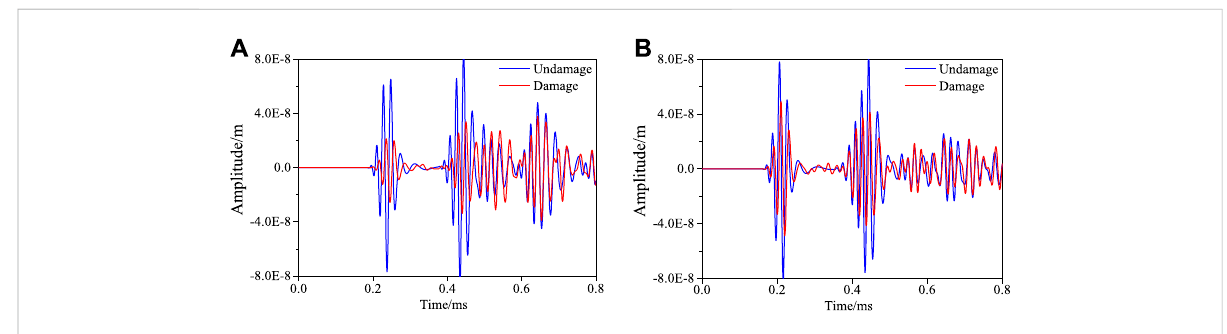
FIGURE 8 Comparison of signals before and after damage. (A) S1 – S7 single sensing channel. (B) S5 – S9 single sensing channel.